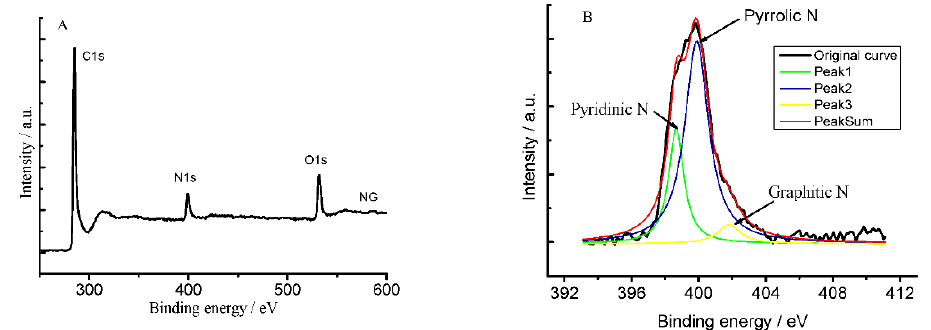
Figure 1. A wide-scan XPS spectrum of as-synthesized NG sample ( A ) and the high-resolution spectrum of N 1s in NG sample ( B